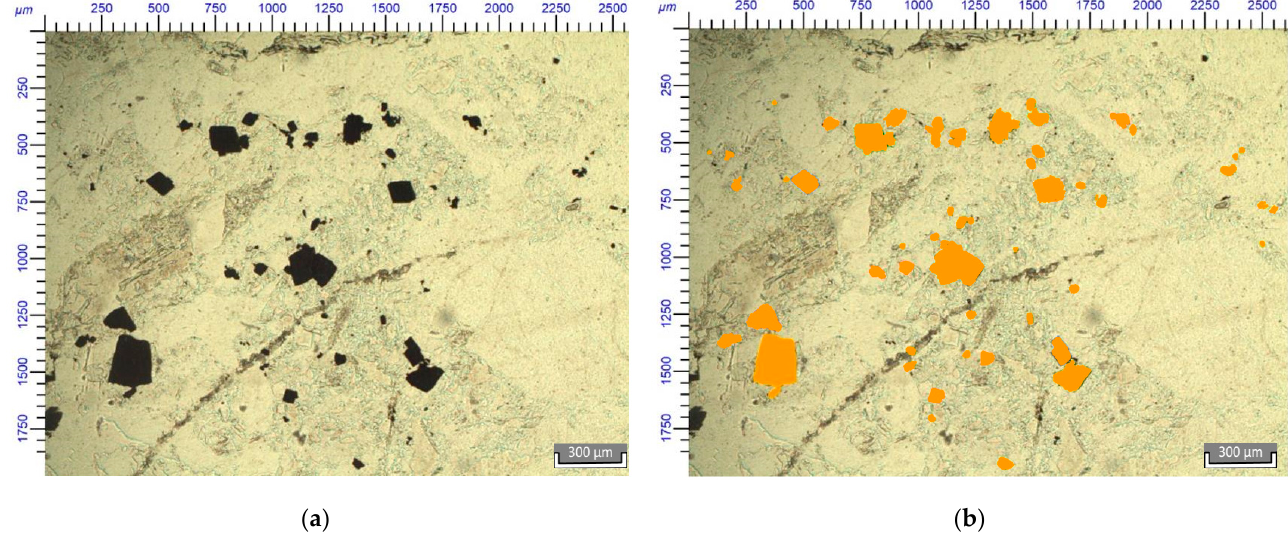
Figure 4. Measurement areas of ore mineralization BDO: ( a ) general view; ( b ) after treatment (ore mineralisation is highlighted in orange color). Table 4. The results of linear measurements for ore mineralization CNO and